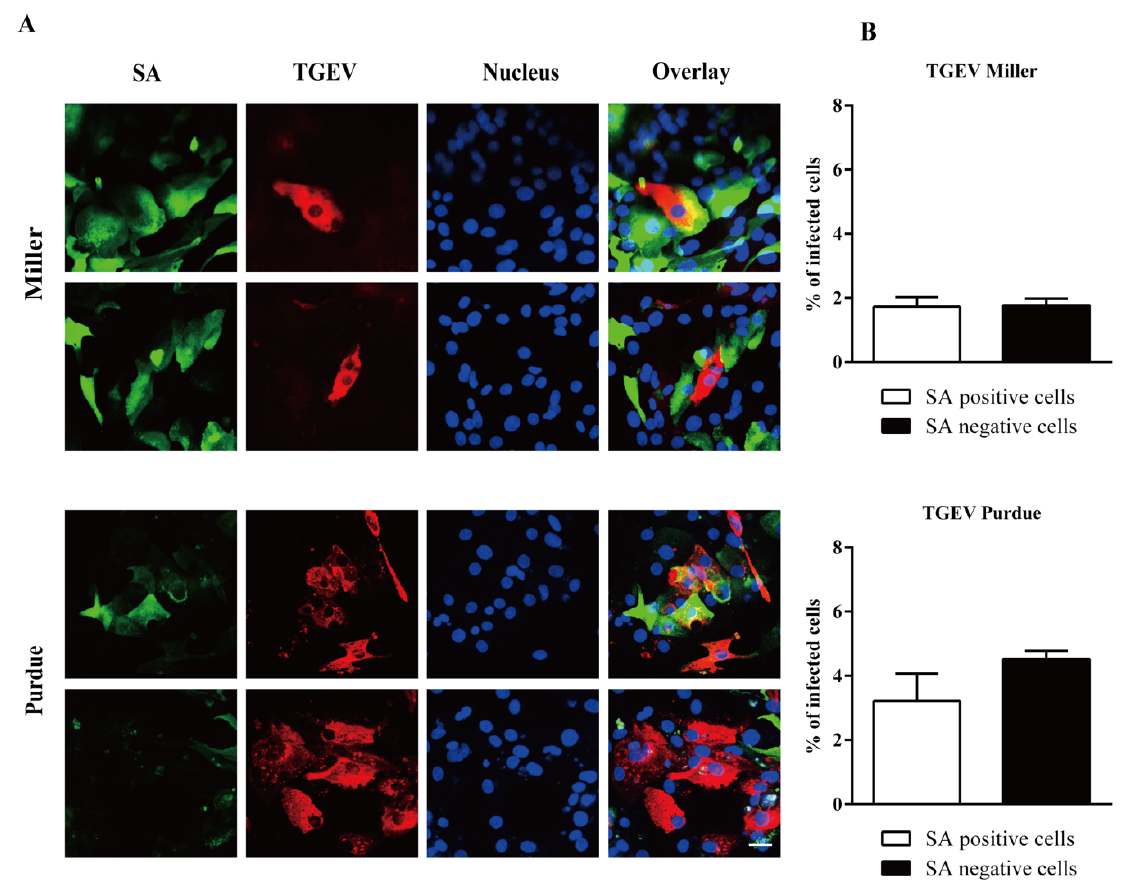
Figure 6. Infection of TGEV in sialic acid positive / negative enterocytes. ( A ) Double immunofluorescence staining of TGEV in primary enterocytes. Scale bar: 25 µ m. ( B ) The percentage of infection among sialic acid positive and negative cells. Data are expressed as the mean ± SD of the results of three separate experiments.